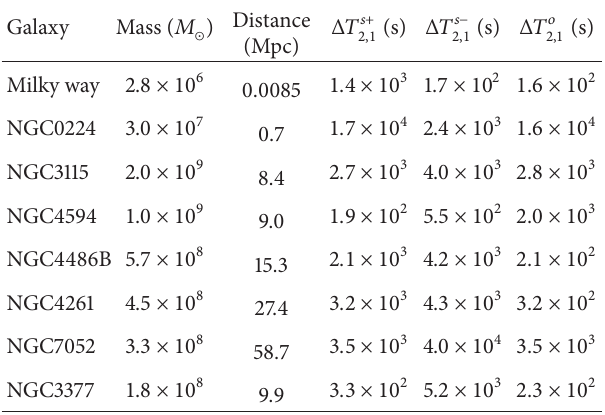
Table 7: Estimation of time delays of the supermassive BHs located at the center of galaxies for ordinary global monopole ( 𝜉 = 1 ) with 𝜂 = 0.25